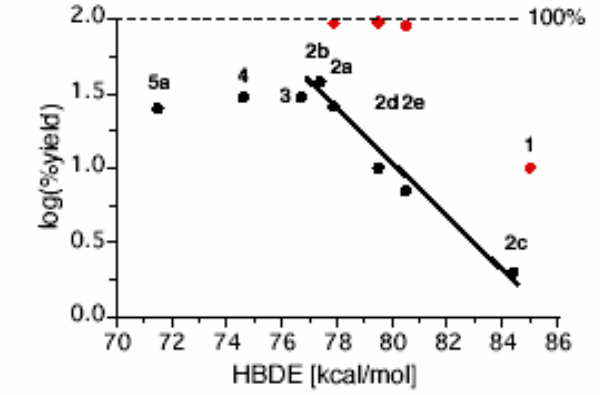
Figure 3 . A plot of log(% yield) vs Homolytic Bond Dissociation Energy (HBDE) for selected radicals generated with PbO 2 /K 2 CO 3 in benzene (circles) and AgO/K 2 CO 3 in MeCN/toluene (red diamonds). The best fit line for 2 (circles): log(%yield) = 15.3-0.18 × HBDE ( R 2 =